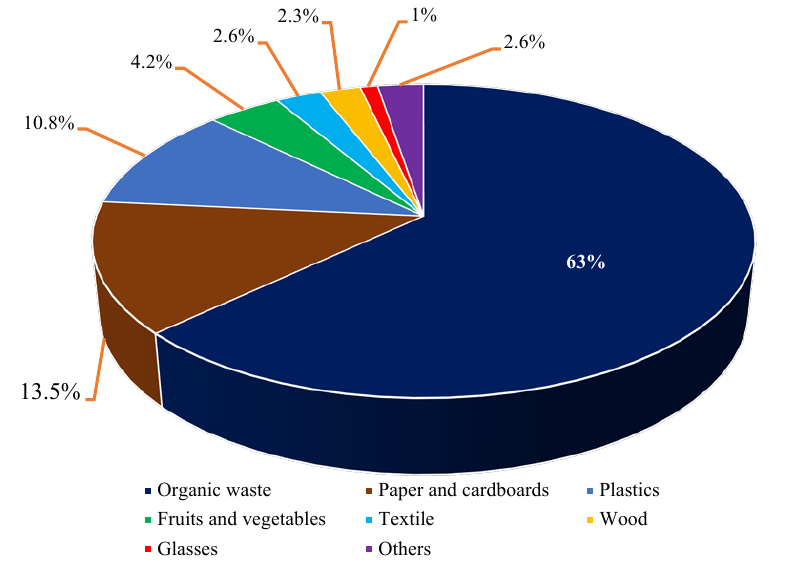
Figure 2. Solid Waste Composition Figure 2. Solid waste Sources of Wastes Generated